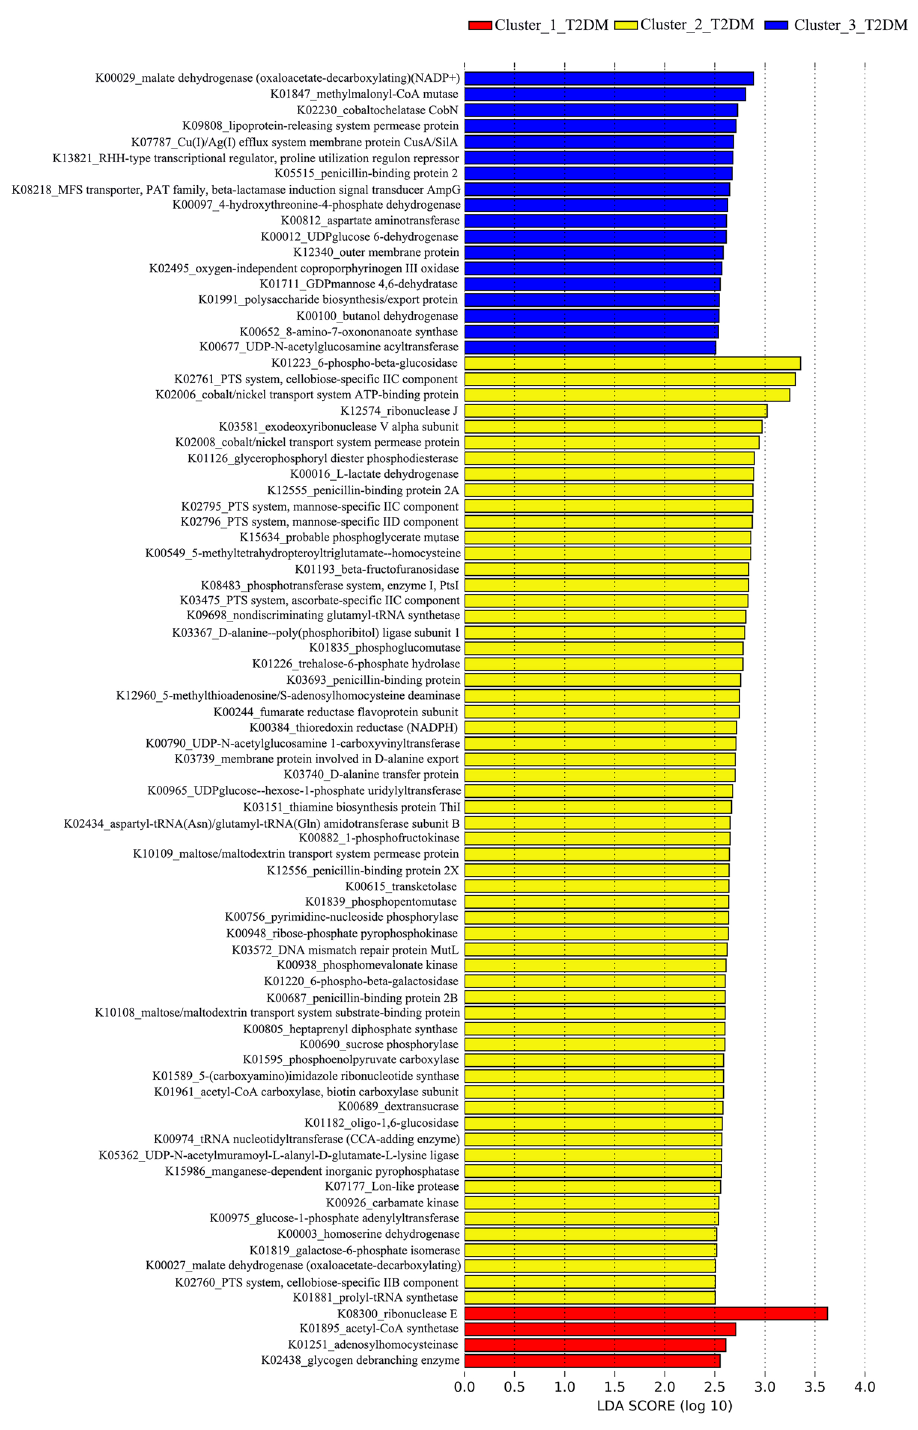
Figure 6. Functional metabolites associated with each of the three clustered T2DM microbiomes determined by LEfSe analysis. Note: the analysis was done on the Huttenhower online software (http://hutte nhowe r.sph. harva rd.edu/galax